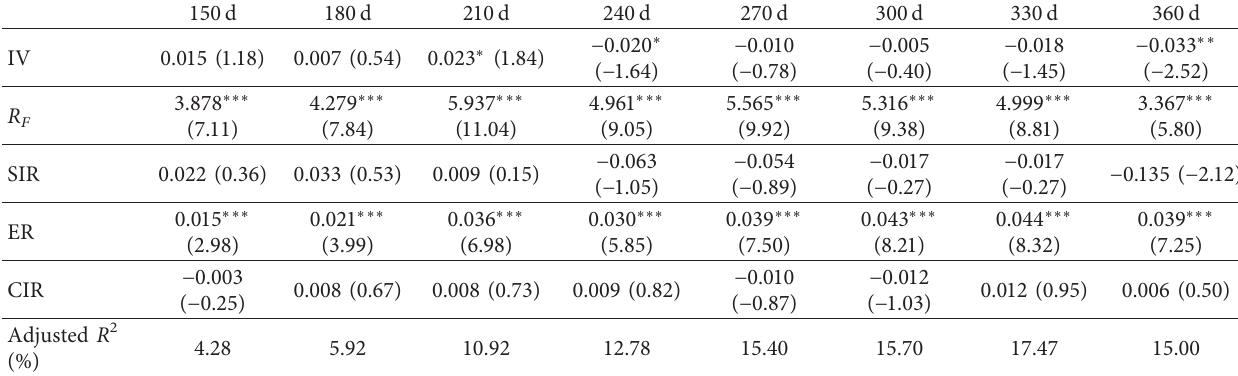
Table 4: Medium- and long-term forecasting power of IV on stock market liquidity.